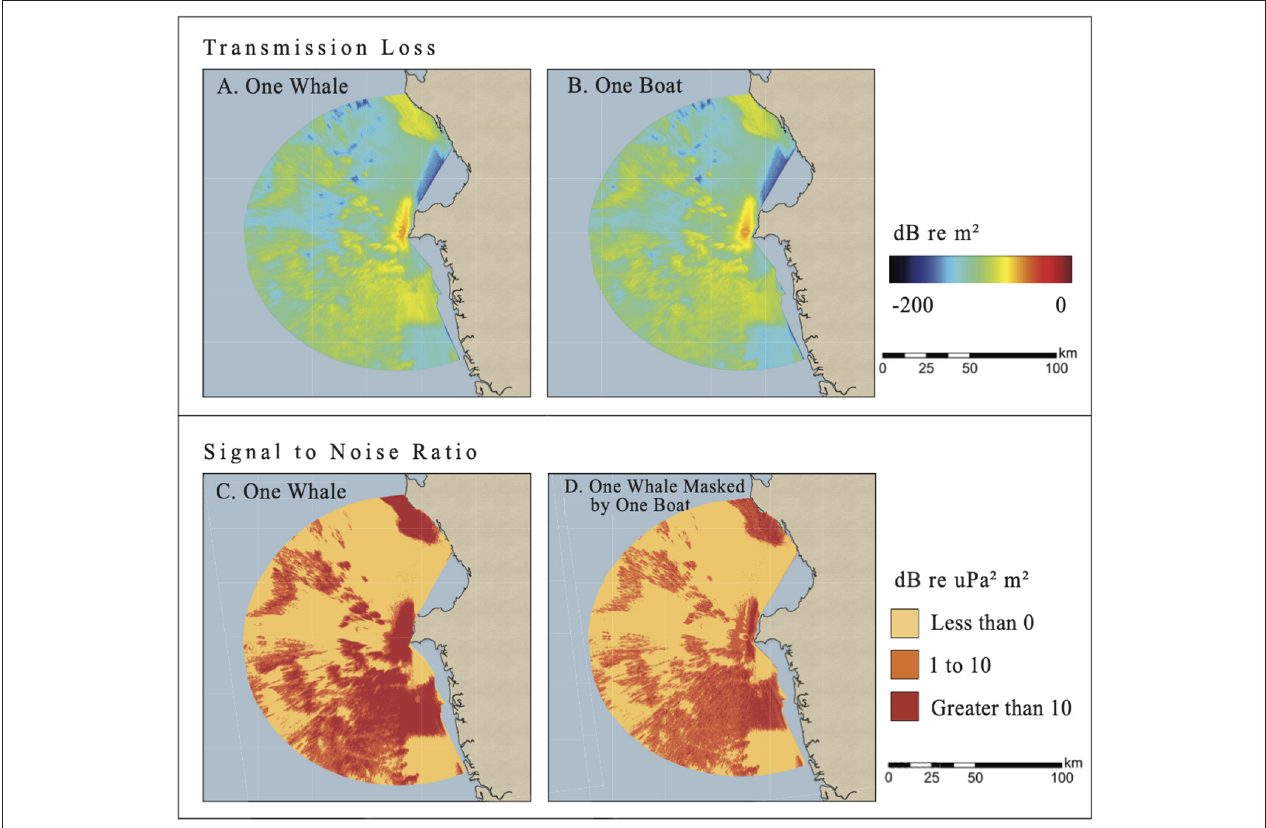
FIGURE 2 | Planview maps for the Sept 5, 2019, scenario #1 of continuous TL values of whale song (top left) and boat noise (top right) illustrate sound transmission loss near Arusí. Blue is less audible while red is more audible. Planview maps as binned SNR values better visualize the area of relatively higher SNR communication space when only ambient noise (bottom left) vs. one boat (bottom right) is present. Red indicates very audible areas of the whale song, orange indicates unreliably audible areas, and yellow indicates masked areas. Source level of the whale’s hypothetical song was 153 dB re 1 µ Pa @ 1 m, which would be dark red in the top left map (color